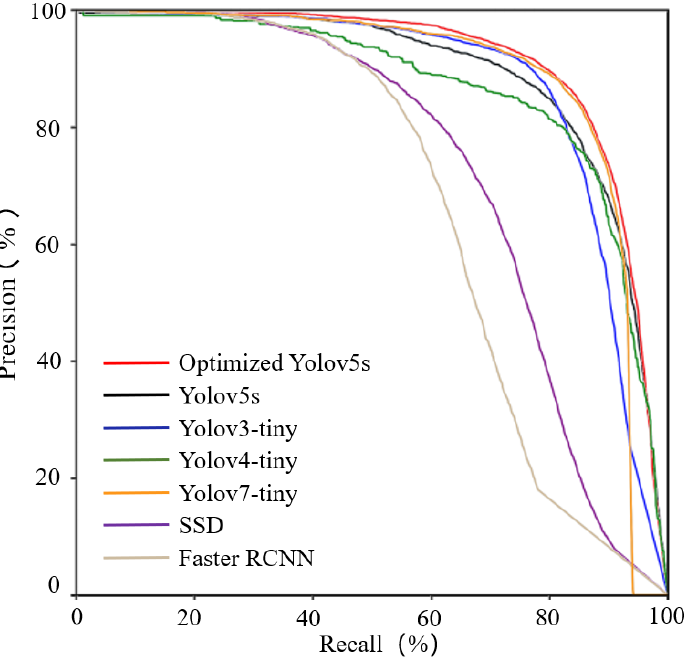
Figure 12. The PR curve of winter jujubes with different target detection algorithms.